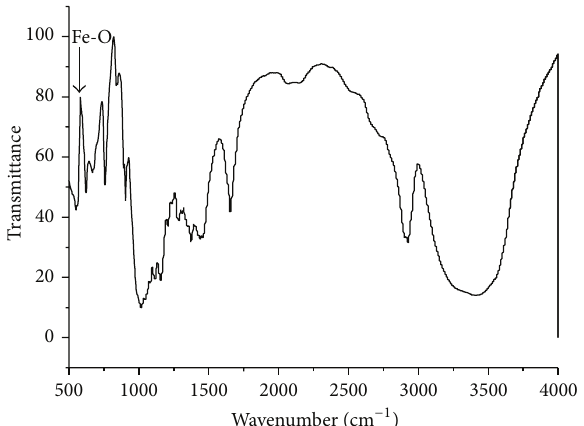
Figure 3: Infrared absorption spectrum of the glucan-Fe 3 O 4 nanoparticles.